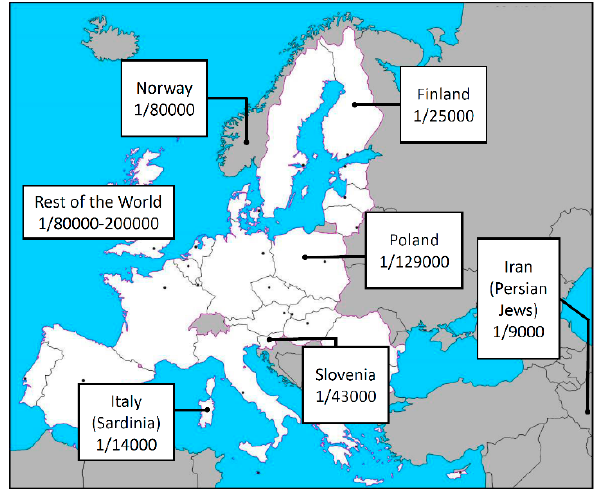
Figure 1 . Prevalence of the APS-1 in different European countries and in the rest of the